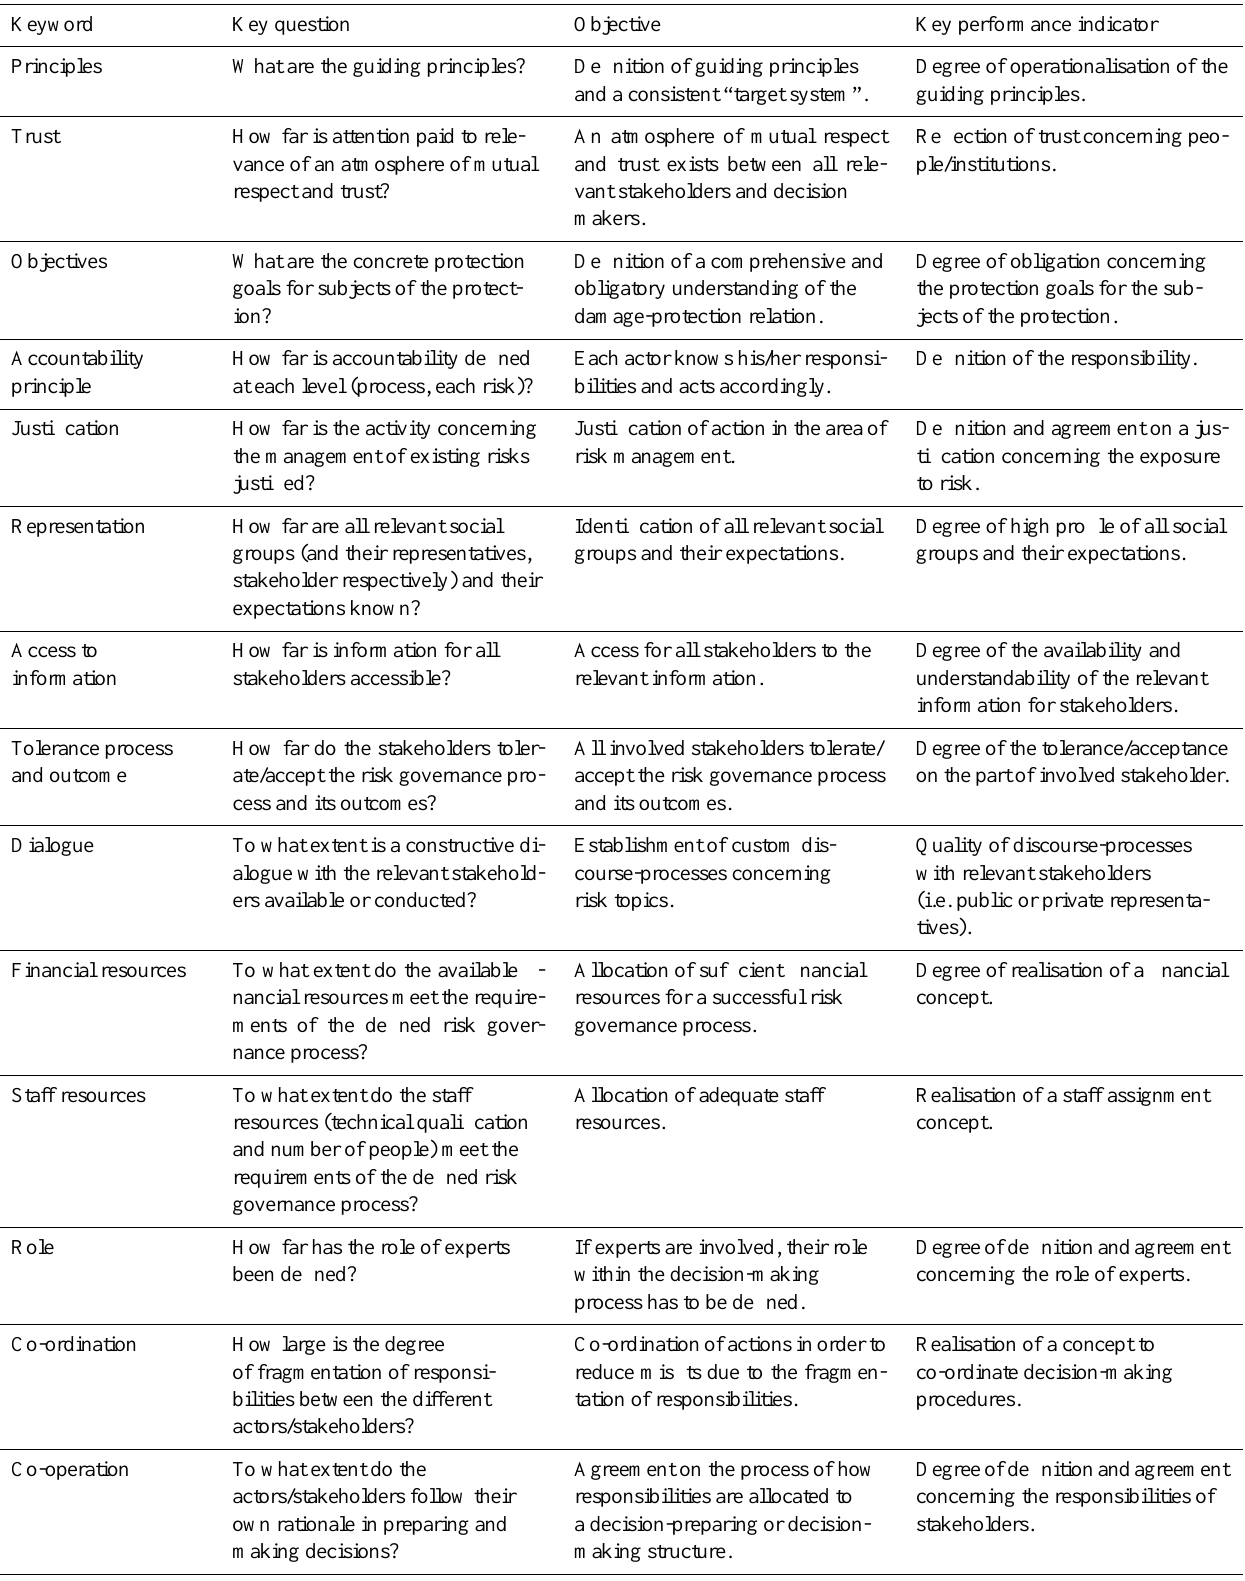
Table 2. Overview of key performance indicators (source: MIDIR project; 2008, p.